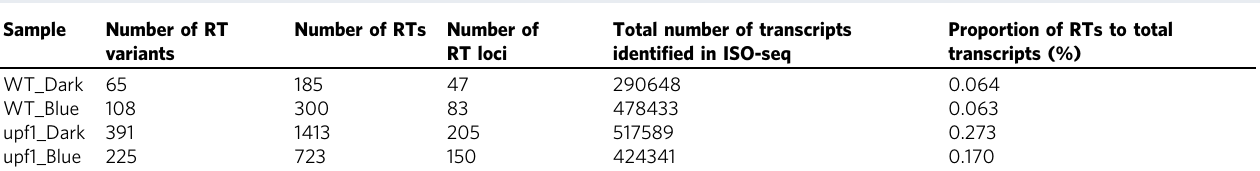
Table 1 Summary of ISO-seq analysis for identi fi cation of RTs.